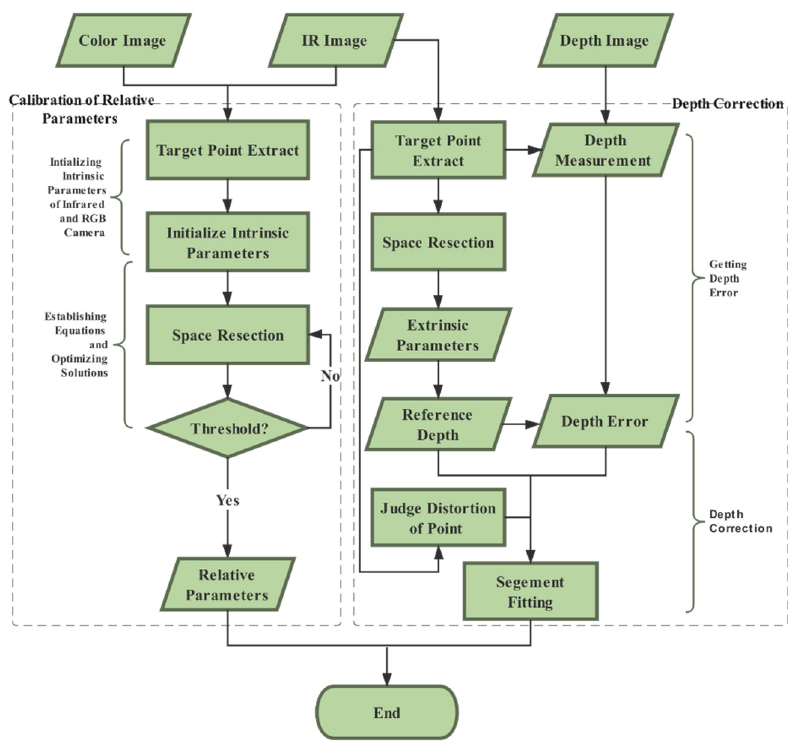
Figure 2. An overview of our proposed calibration method.